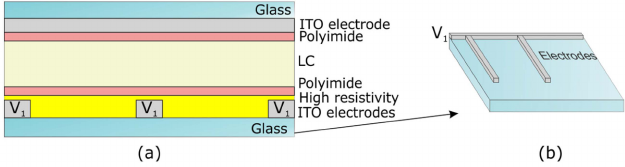
Figure 11. Structure of a liquid crystal cylindrical lens based on modal control technique: ( a ) 2D view and ( b ) 3D view of the bottom substrate, detail of the electrode